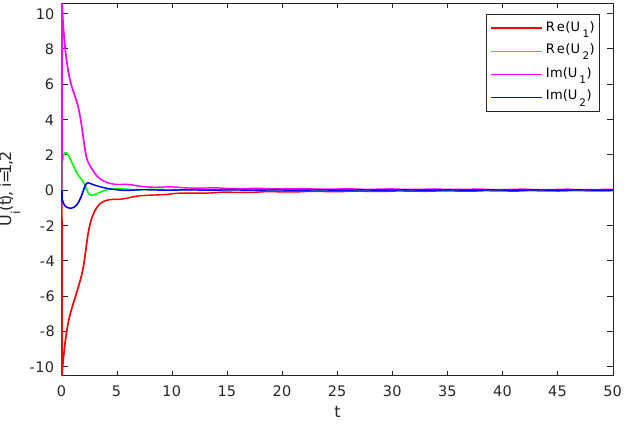
Figure 9. Synchronization evolution of x 2 ( t ) and y 2 ( t ) under the controller (18).